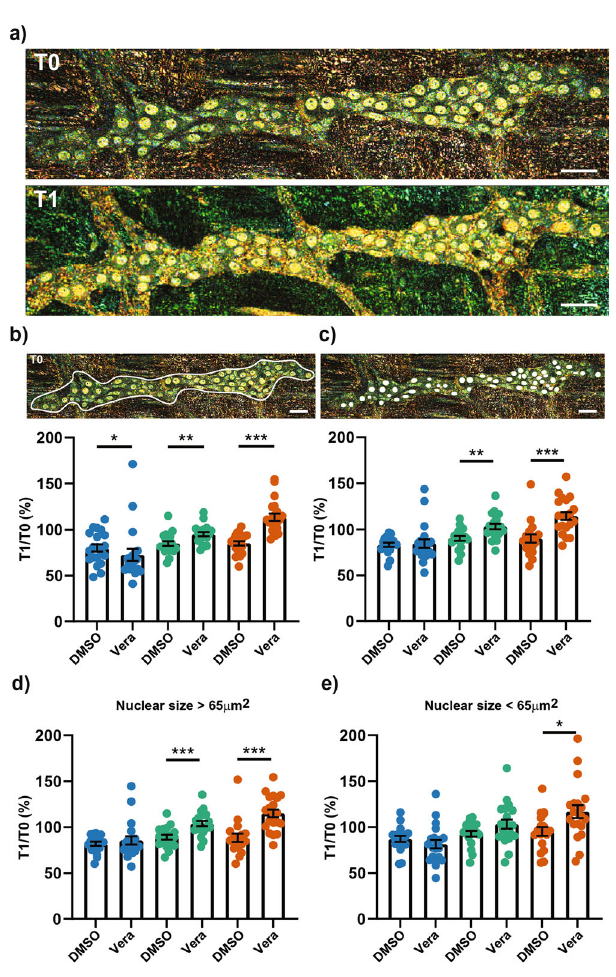
Fig. 4 Effect of veratridine on D-FFOCT signal. a D-FFOCT micrograph of the same ganglia visualized before (T0) and after a 30 min treatment with 75 µ M veratridine (T1). Scale bar: 30 µ m. b , c T1:T0 ratio expressed as percentage of the mean intensity for low (blue), medium (bluish green), or high (vermillion) range of frequency after a treatment with vehicle (0.1% vol/vol DMSO) or 75 µ M veratridine (Vera). Mean intensity was calculated from the whole ganglia ( b ) or from the nuclear structure ( c ) as indicated in the upper part of the panel. d , e Same experiment as in ( c ) but the nuclei were subdivided in function of their size >65 µ m ( d ) and <65 µ m ( e ). Veratridine, n = 20 ganglia from 4 mice; DMSO, n = 20 ( b , d ) or 18 ( c , e ) ganglia from 4 mice. Mean value + / − SEM; Statistic: two-tailed Mann and Whitney t-test. * p < 0.05; ** p < 0.01, *** p <